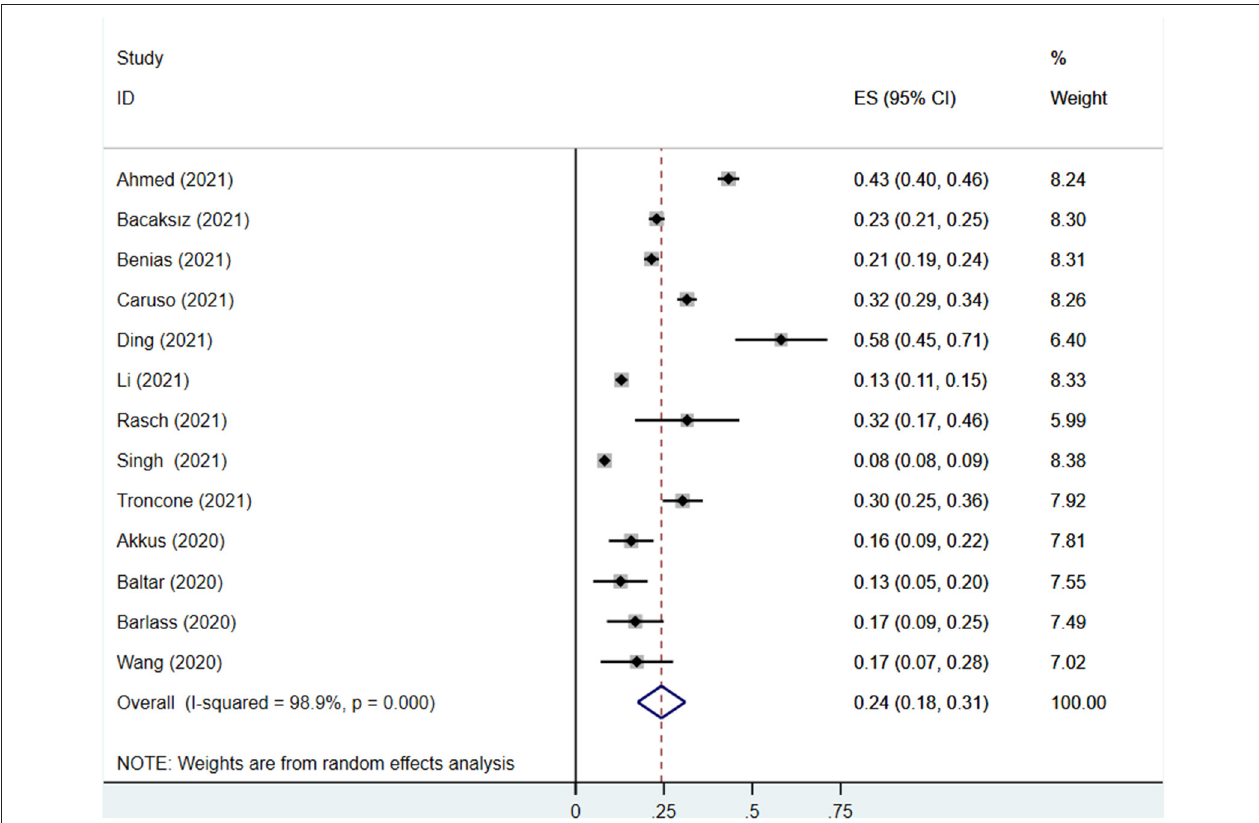
FIGURE 2 | Effect size analysis for the prevalence of PE elevation in COVID-19 patients.